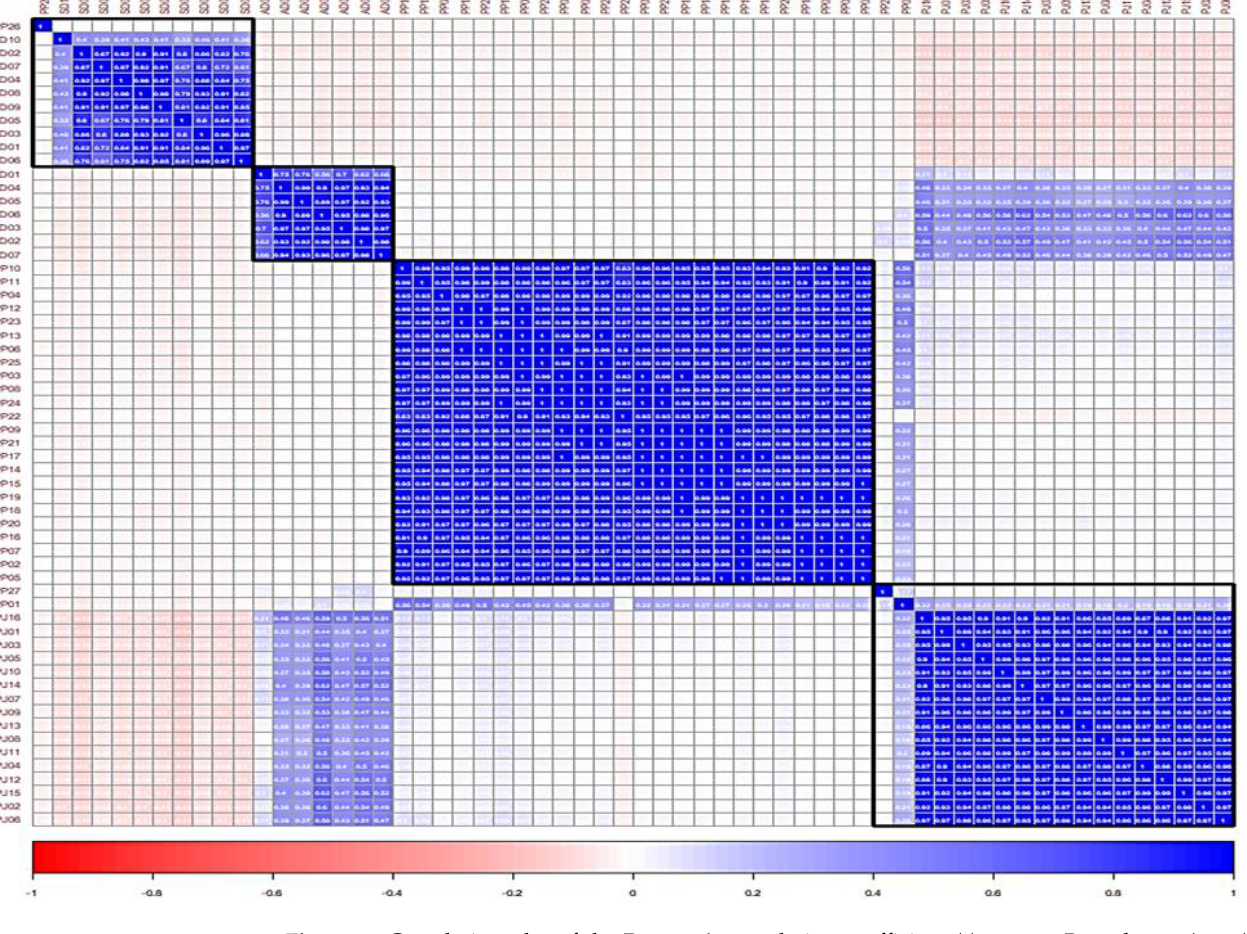
Figure 5. Correlation plot of the Pearson’s correlation coefficient ( r ) among Peucedanum japonica , P. praeruptorum , Angelica decursiva , and Saposhnikovia divaricata samples. The range of the coefficient is –1 (red color) < r < 1 (blue color). PJ: Peucedanum japonicum , PP: P. praeruptorum , AD: Angelica decursiva , SD: Saposhnikovia divaricata . Table 4. Pearson’s correlation coefficients among PJ, PP, AD, and SD samples.